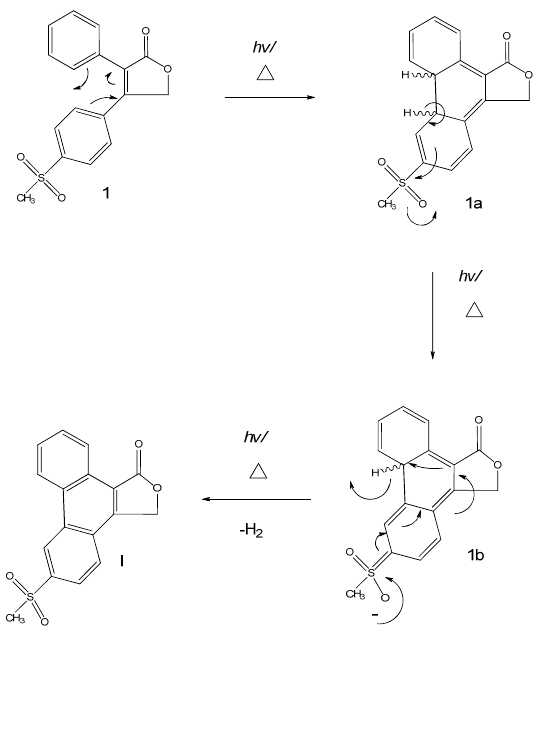
Figure 8. Mechanistic Scheme for the formation of I